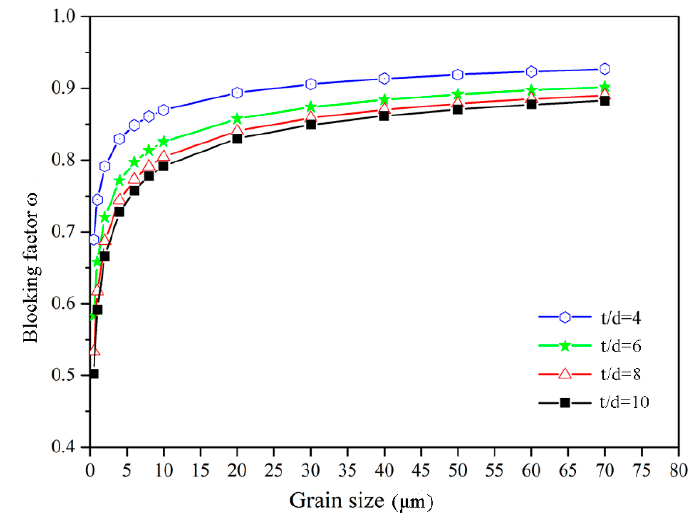
Figure 7. The variation of blocking factor ω with the grain size.